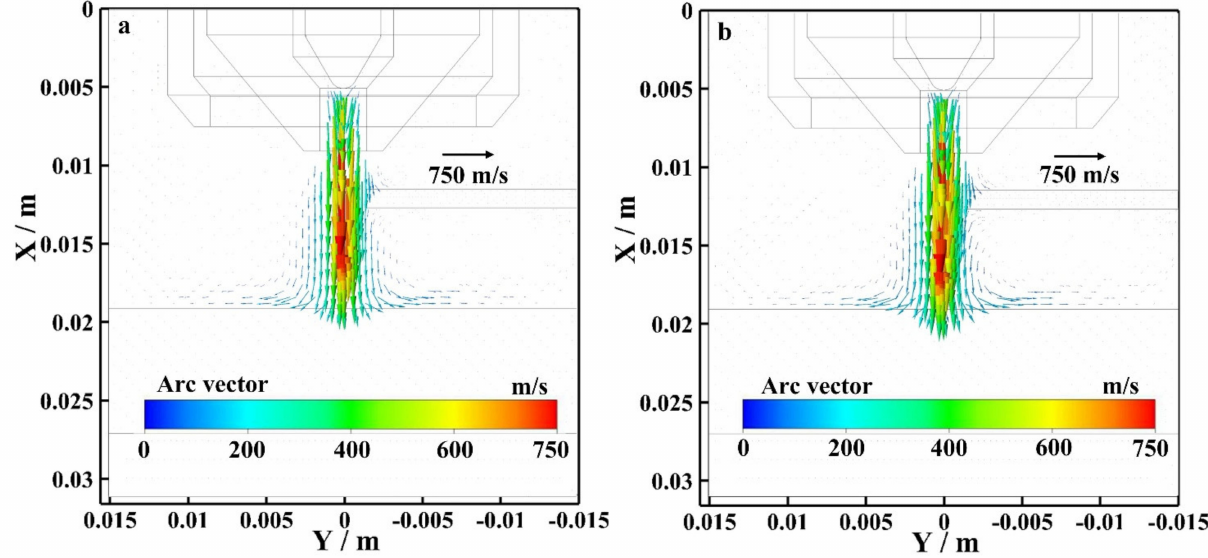
Figure 9. Flow field distribution of bypass coupling arc at EN phase with and without bypass current, ( a ) 120 A and 0 A, ( b ) 60 A and 60